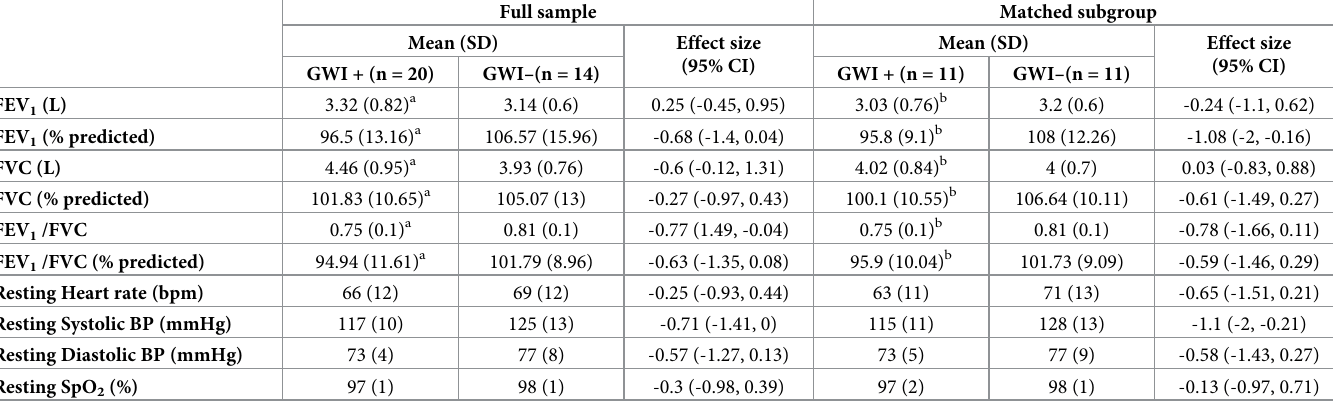
Table 2. Comparison of mean (SD) spirometric indices, and resting heart rate, blood pressure, and arterial blood oxygen saturation between participants with posi- tive and negative Gulf War Illness diagnoses.